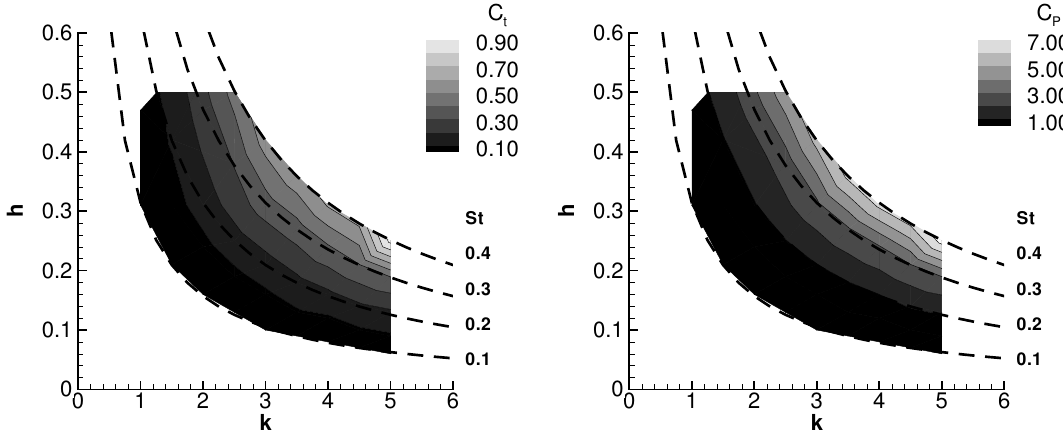
Figure 6. Mean thrust and power coefficients with Re =